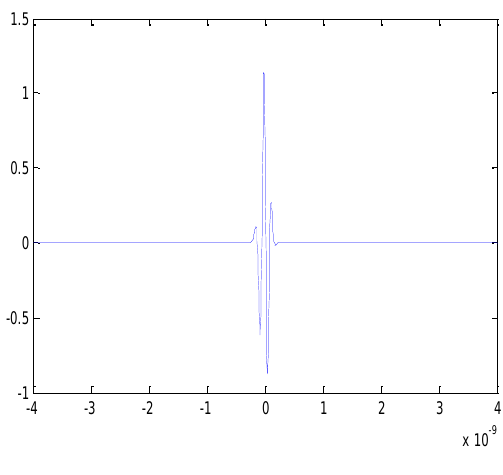
Fig.8. Optimal Pulse